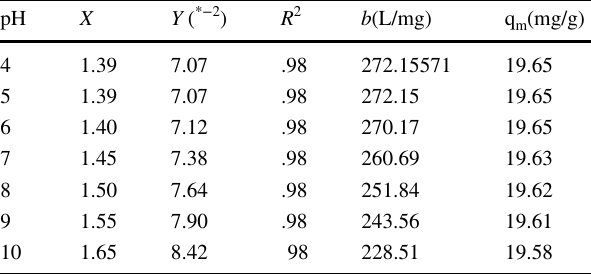
Table 7 Langmuir parameters for mercury adsorbed by granular